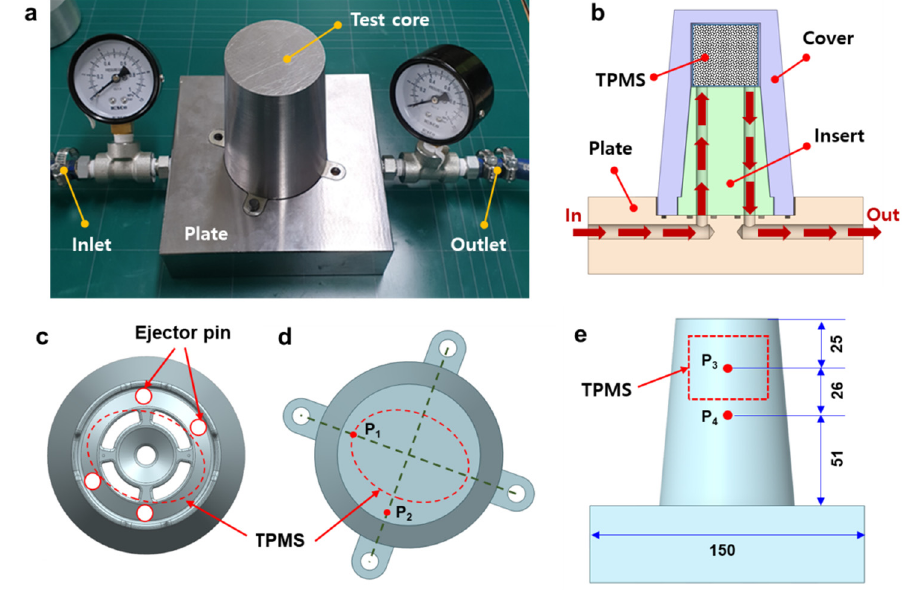
Figure 4. Description of the mold heating test: ( a ) Experimental setup. ( b ) Sectional configuration of the test mold. ( c ) Position of the ejector pins and the TPMS cooling structures. ( d ) Sample measurement points on the top surface (P 1 and P 2 ). ( e ) Sample measurement points on the side surface (P 3 and P 4 ).